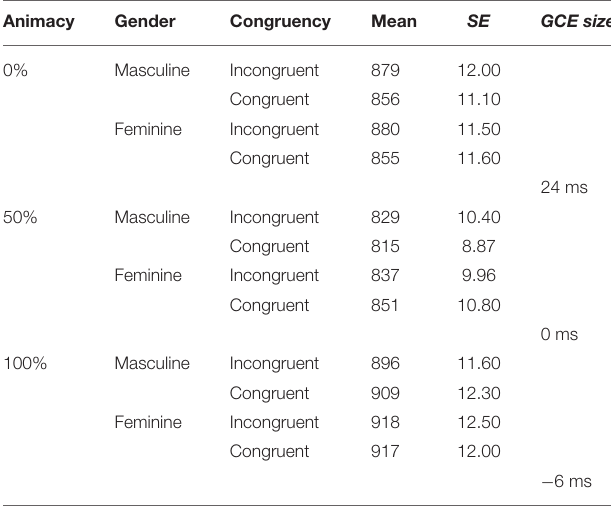
TABLE 4 | Mean reaction times and standard errors (SE) for each condition in Experiment 1.